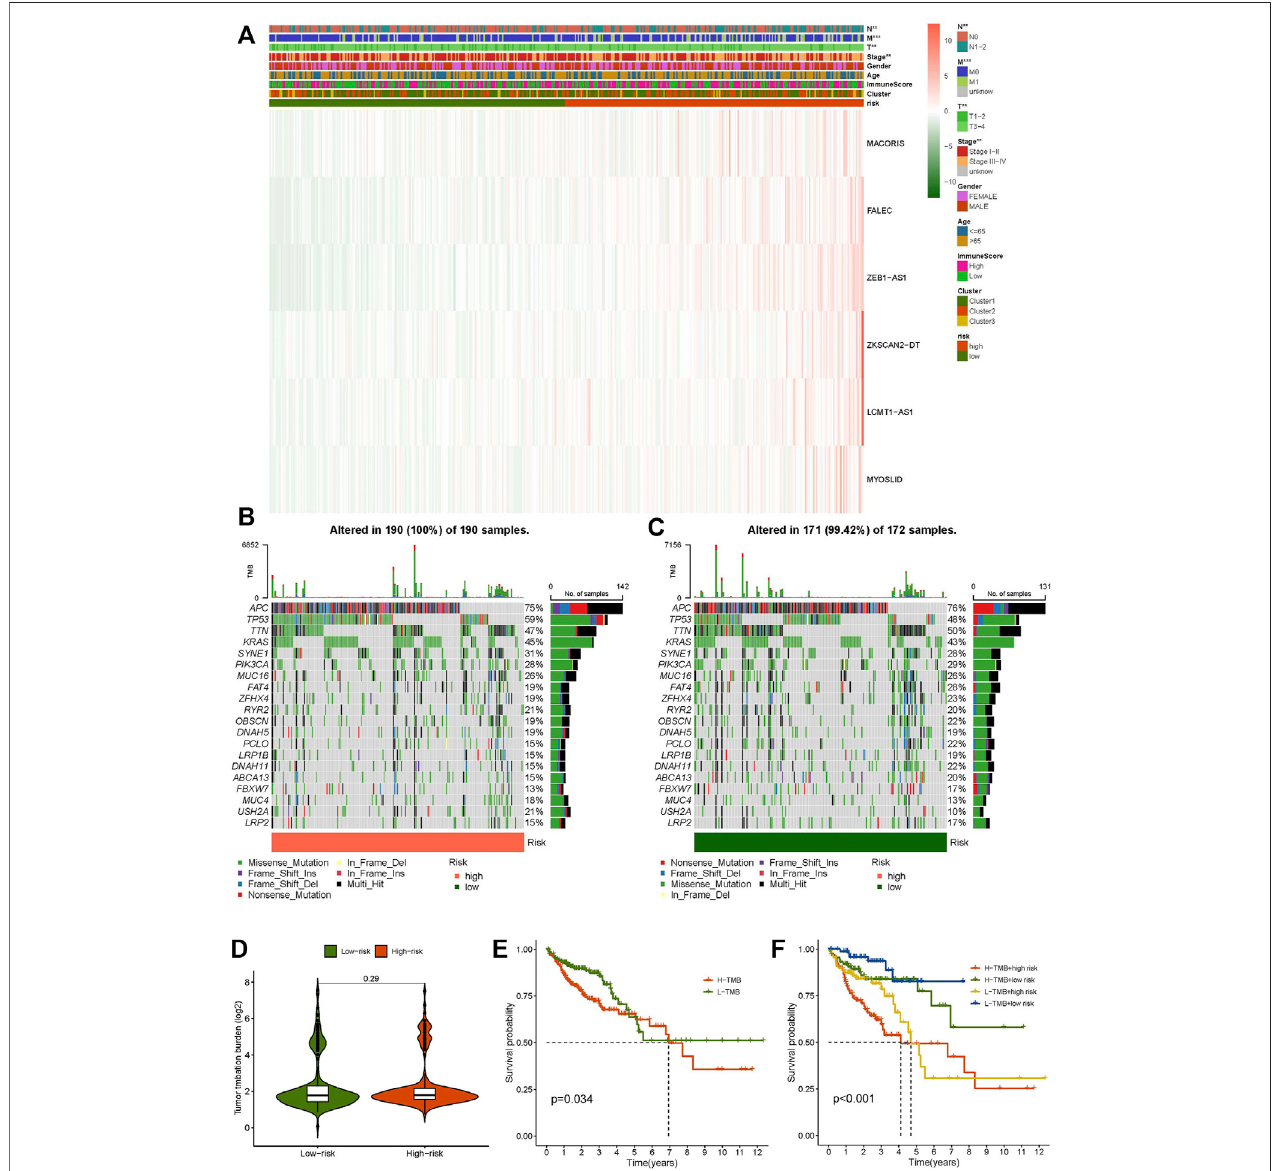
FIGURE7| Clinicopathologicalfeaturesinthehigh-andlow-riskscoregroup,TMEanalysis. (A) Heatmapofclinicopathologicalfeaturesinthehigh-andlow-riskgroup. (B) Waterfallplotdisplaysmutationinformationofthegeneswithhighmutationfrequenciesinthehigh-riskgroup. (C) Waterfallplotdisplaysmutationinformationofthegenes withhighmutationfrequenciesinthelow-riskgroup. (D) TMBdifferenceinthehigh-andlow-riskpatients. (E) Kaplan – MeiercurveanalysisofOSisshownforpatientsinhigh and low TMB. (F) Kaplan – Meier curve analysis of OS is shown for patients classi fi ed according to the TMB and necroptosis-related lncRNA model.